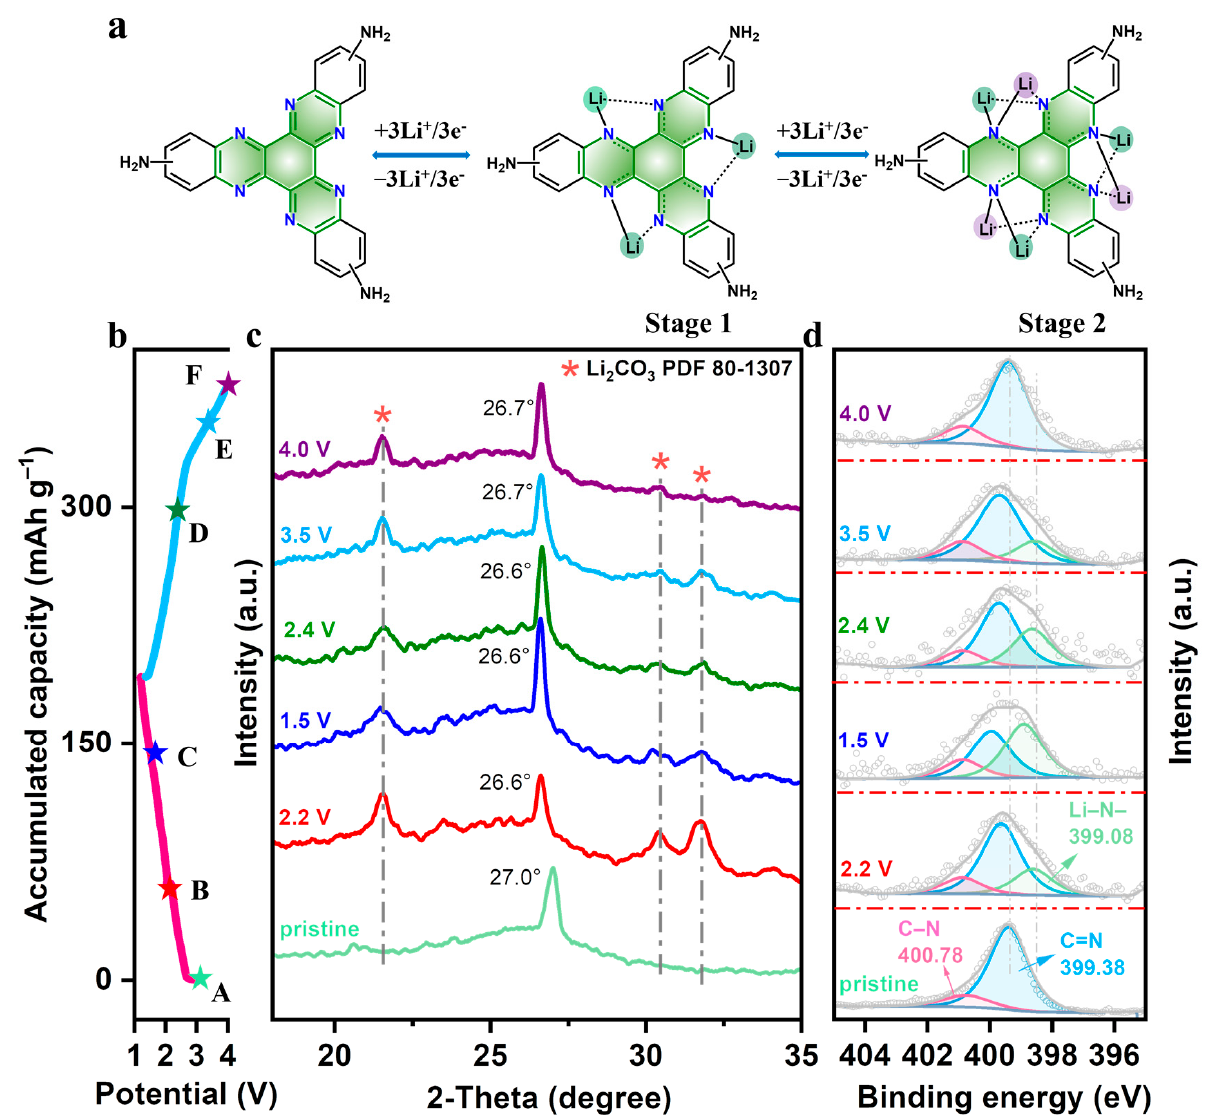
Figure 4. ( a ) The configurations of HATN-[NH 2 ] 3 , Li 3 HATN-[NH 2 ] 3 , Li 6 HATN-[NH 2 ] 3 . ( b ) The initial galvanostatic discharge and charge curves of HATN-[NH 2 ] 3 electrodes with marked points at diverse discharge and recharge states at 50 mA g − 1 . ( c ) Ex-situ XRD patterns and ( d ) ex-situ high-resolution XPS N 1s spectra for the samples taken at different states as marked by a pristine, 2.2 V discharged, 1.5 V discharged, 2.4 V charged, 3.5 V charged, 4.0 V charged in ( b ). (pristine: freshly prepared electrode sheets without any treatment).